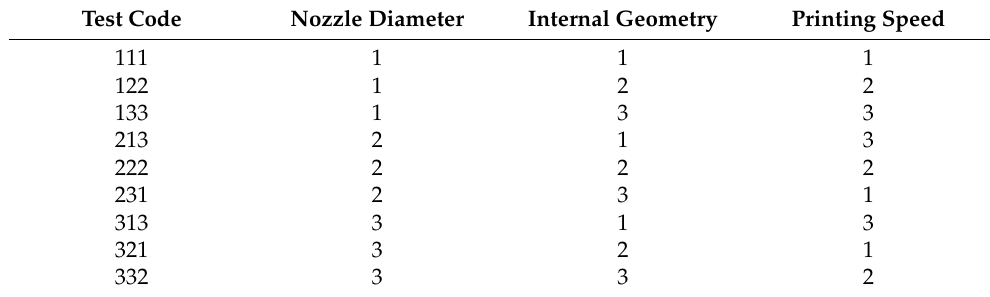
Table 3. L 9 Orthogonal